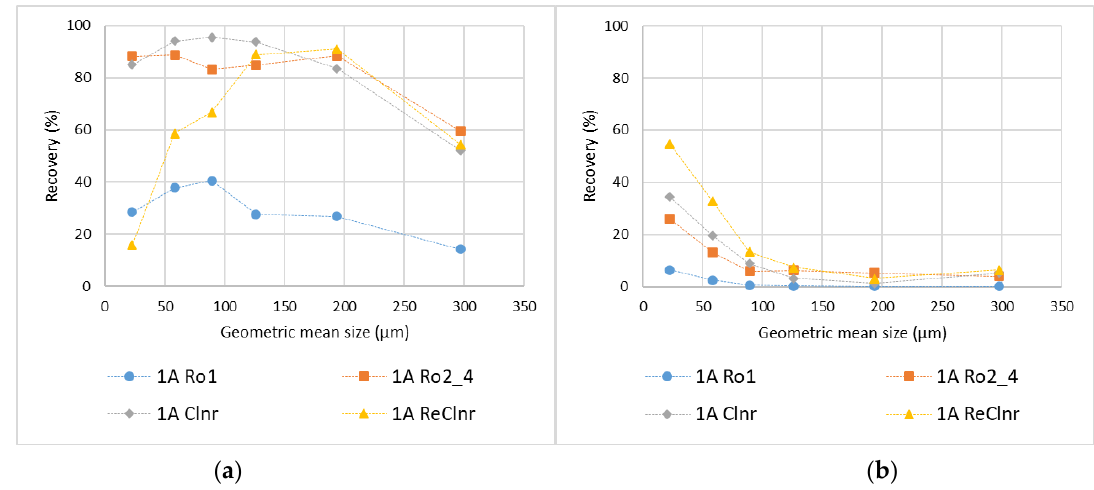
Figure 3. Recovery-by-size of line 1 bank A for ( a ) SiO 2 , and ( b ) Fe 2 O 3 (1A refers to line 1 bank A, Ro refers to rougher, Clnr refers to cleaner, and ReClnr refers to recleaner).